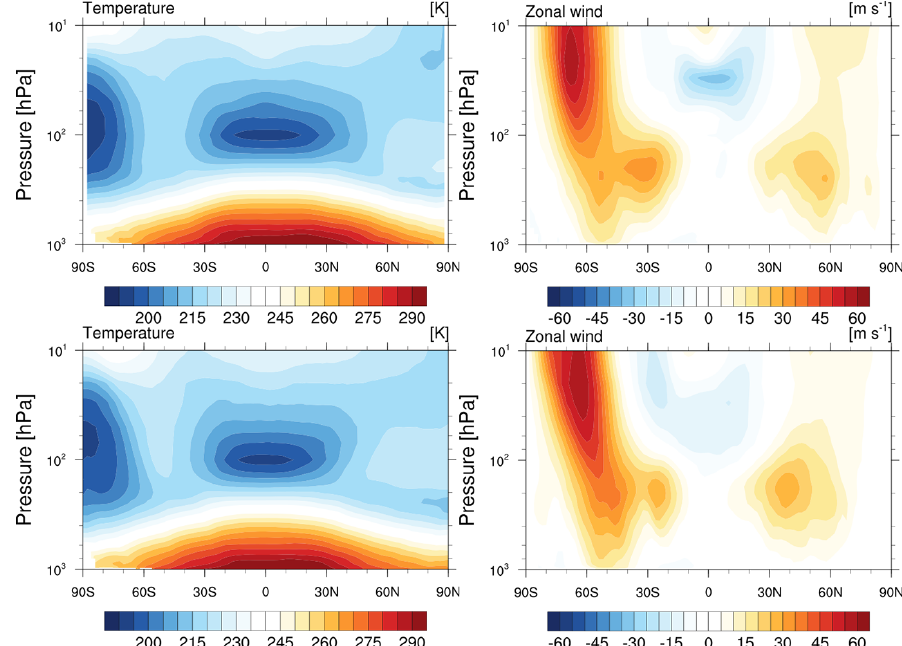
Figure 3. Zonal mean of temperature (left column) and zonal wind (right column) at 1 October 2012 as given by ERA-Interim reanalysis (top row) and ICON–ART (bottom